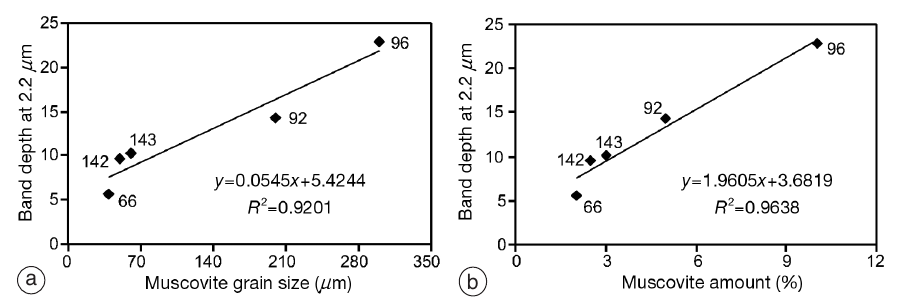
Fig. 6a,b. Relationship between 2200 nm Al-OH band of muscovite in quartzite, and muscovite grain size (a) and abundance (b). The relationship is linear in these rocks, where muscovite is the only spectroscopically ac- tive mineral.